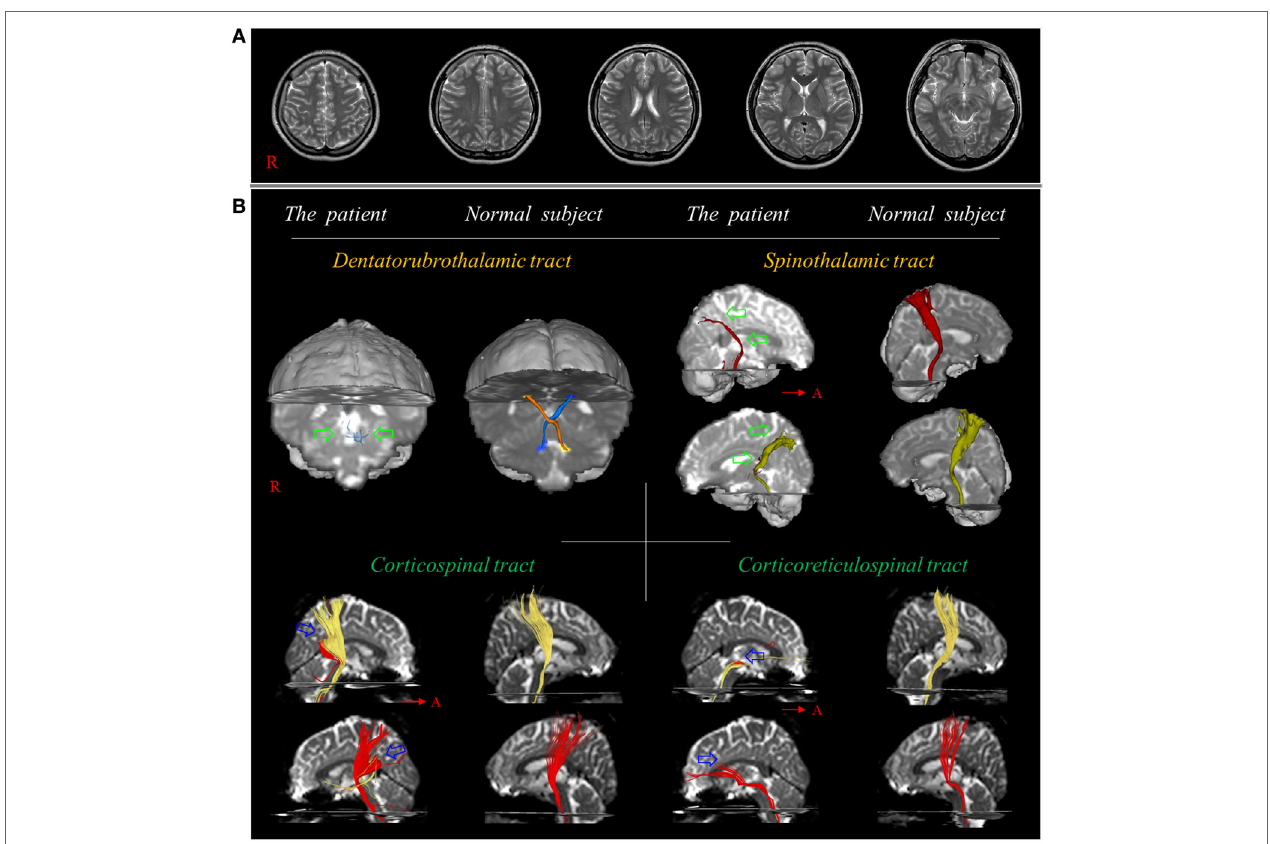
FigURe 1 | (A) T2-weighted brain MR images at 10 weeks after onset show no abnormality. (B) Results of diffusion tensor tractography. Only tiny fibers (green arrows) of the dentato-rubro-thalamic tract are reconstructed at the brainstem level and the spinothalamic tract is thinner in both hemispheres (green arrows) compared with a normal subject (26-year-old female). By contrast, the corticospinal tract and corticoreticulospinal tract show partial tearing and discontinuation at the subcortical white matter level in both hemispheres (blue arrows). Reprinted from Jang and Lee (26) with permission.